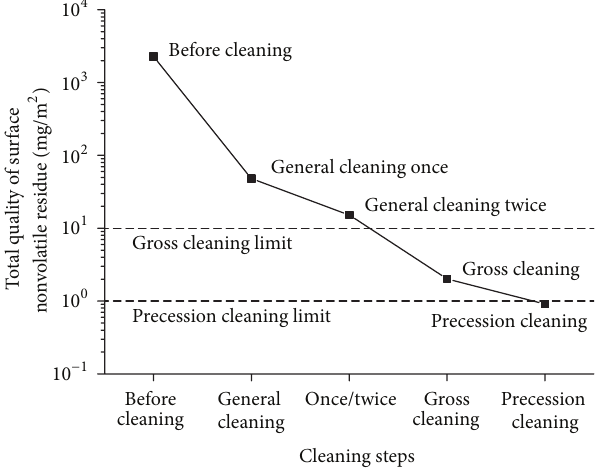
Figure 5: Curves of NVR versus processing steps.